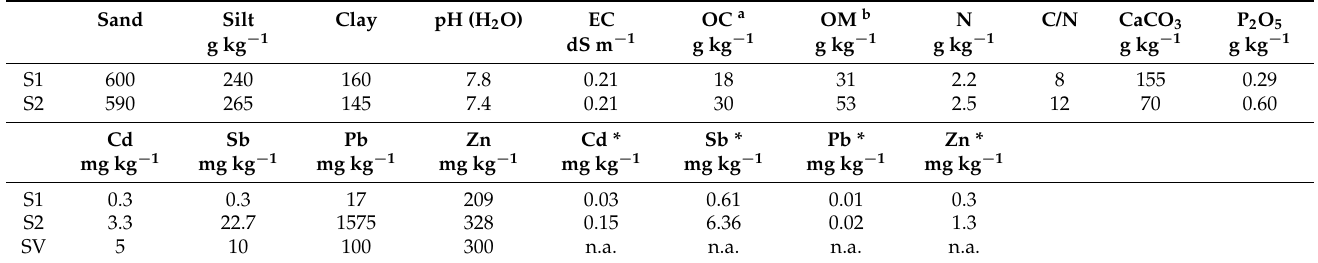
Table 1. Physicochemical properties of the unpolluted (S1) and polluted (S2)